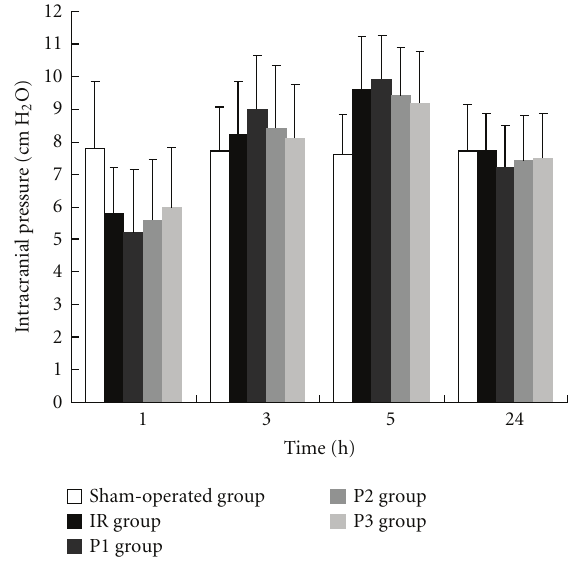
Figure 1: Intracranial pressure of five groups. There were no obviously di ff erences of ICP among five groups in serial time